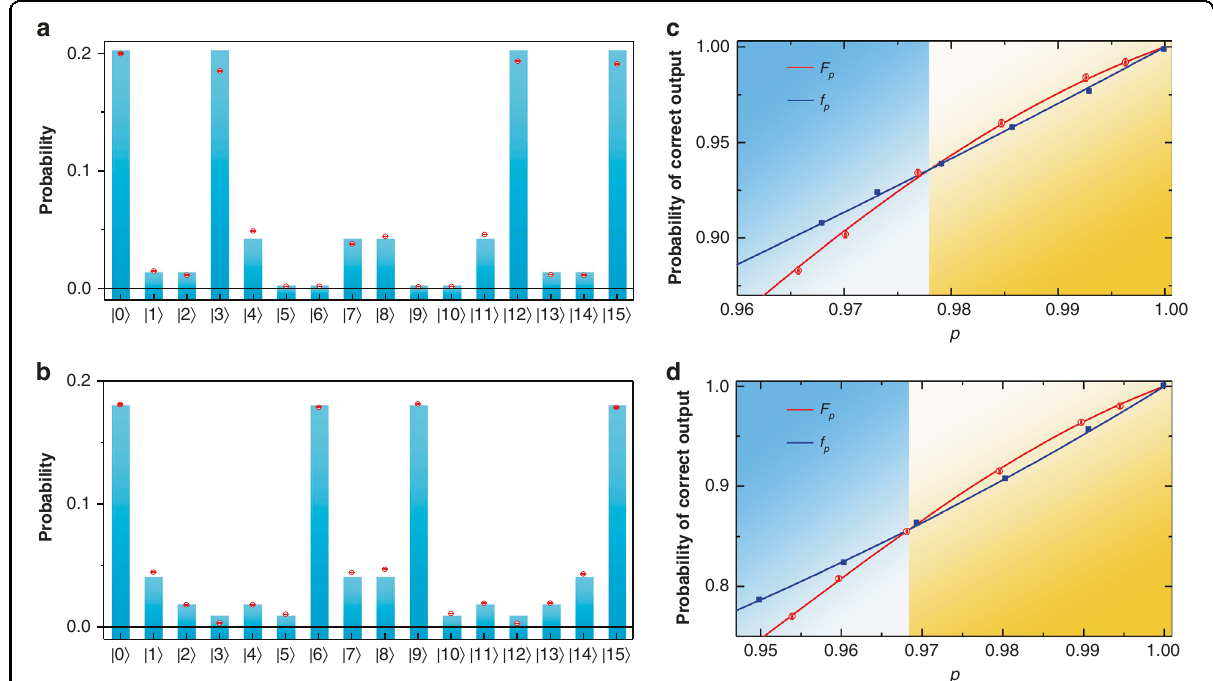
Fig. 4 Experimental probability distributions of 16 optical modes and results of threshold. Probabilities of 16 optical modes in the outputs of the logical operation H 2 and CNOT 21 ·H 2 are shown in a ( p = 0.966) and b ( p = 0.968), respectively. The histograms and red points represent the theoretical and experimental results, respectively. The x-axis represents the basis of optical modes, which are denoted in the decimal form. Panels c , d show experimental probabilities of correct output, F p , according to success probability p = 1 − ò for H 2 and CNOT 21 ·H 2 , respectively. In each panel, as shown in the right yellow region, the probability is above the threshold. Blue and red curves represent theoretical predictions of the non- encoded circuit ( f p ) and fault-tolerant circuit ( F p ), respectively. Blue squares (error bars are too small to show) and red hollow points with error bars indicate the corresponding experimental results. All error bars are estimated as standard deviations of photon counts assuming a Poisson